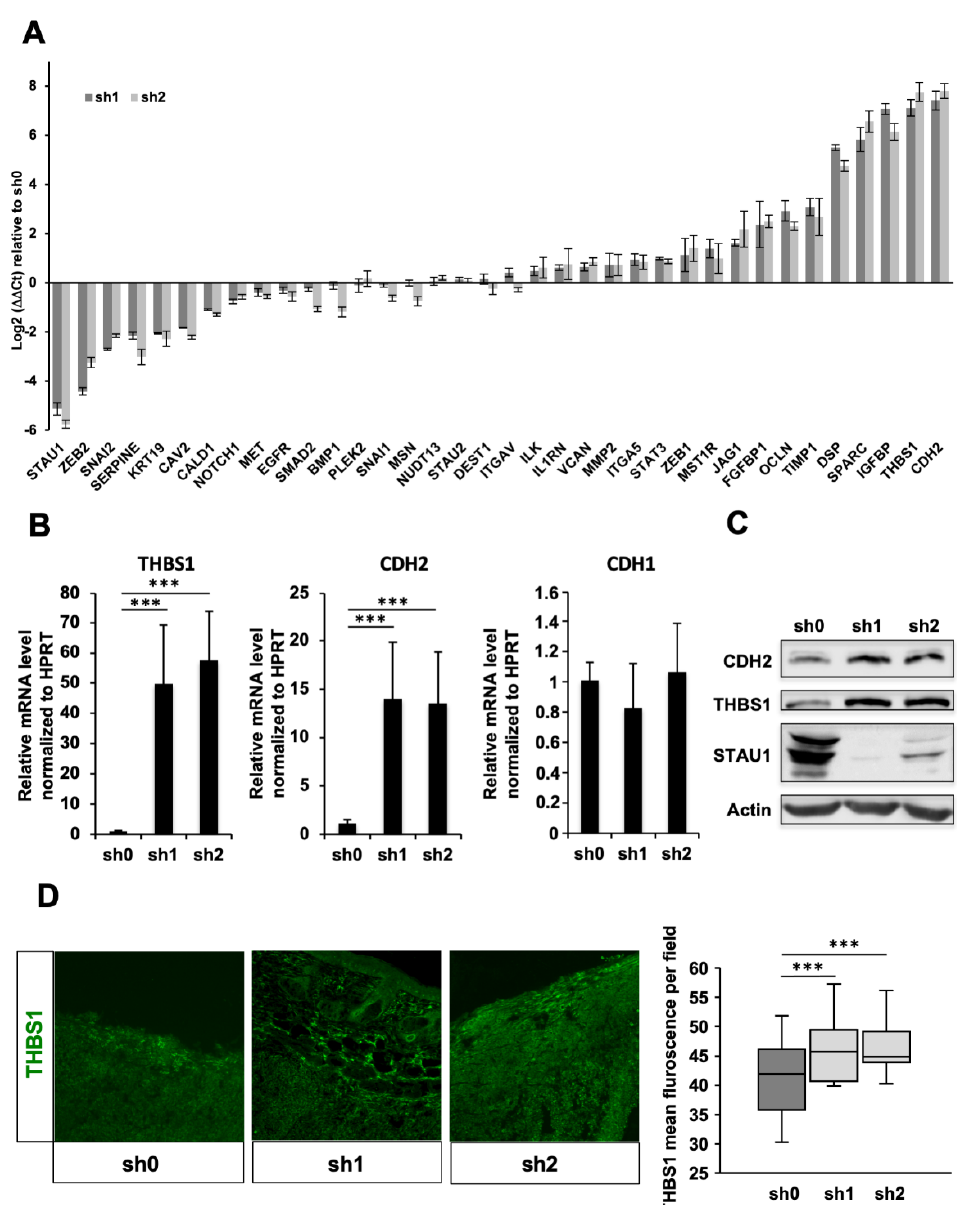
Figure 6. THBS1 and CDH2 expression is strongly increased by Stau1 depletion. ( A ) mRNA level of 35 genes involved in intercellular adhesion, cell adhesion to the extracellular matrix and EMT in sh1 and sh2 H469 cell lines compared to sh0 control cell line. Normalization was performed using HPRT gene. ( B ) THBS1 (left) and CDH2 (middle) mRNA levels are affected by Stau1 knock-down in xenografted tumors whereas CDH1 transcript levels remain unaffected (right). ( C ) The increase of THBS1 and CDH2 mRNA levels corresponds with an increase in THBS1 and CDH2 protein levels in the Stau1 knock-down cells sh1 and sh2 compared to the sh0 control cell line. ( D ) THBS1 protein levels are increased in Stau1 knock-down tumors sh1 and sh2 compared to sh0 control tumors. *** p <